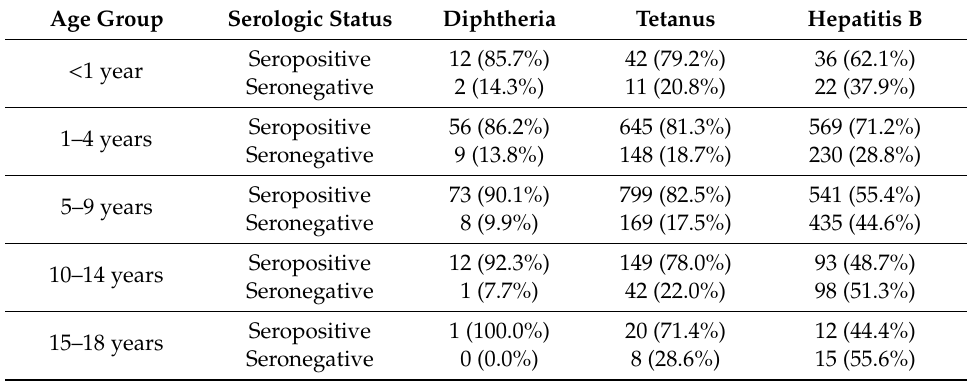
Table A1. Percentages of seropositive and seronegative children in the study for diphtheria, tetanus, and hepatitis B, by age group.